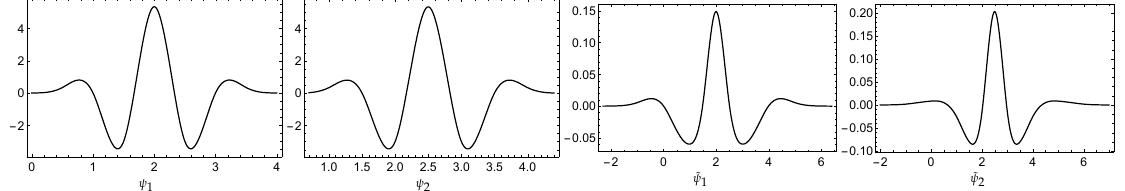
Figure 5. The graphs of the framelets and its dual framelets of Example 3.